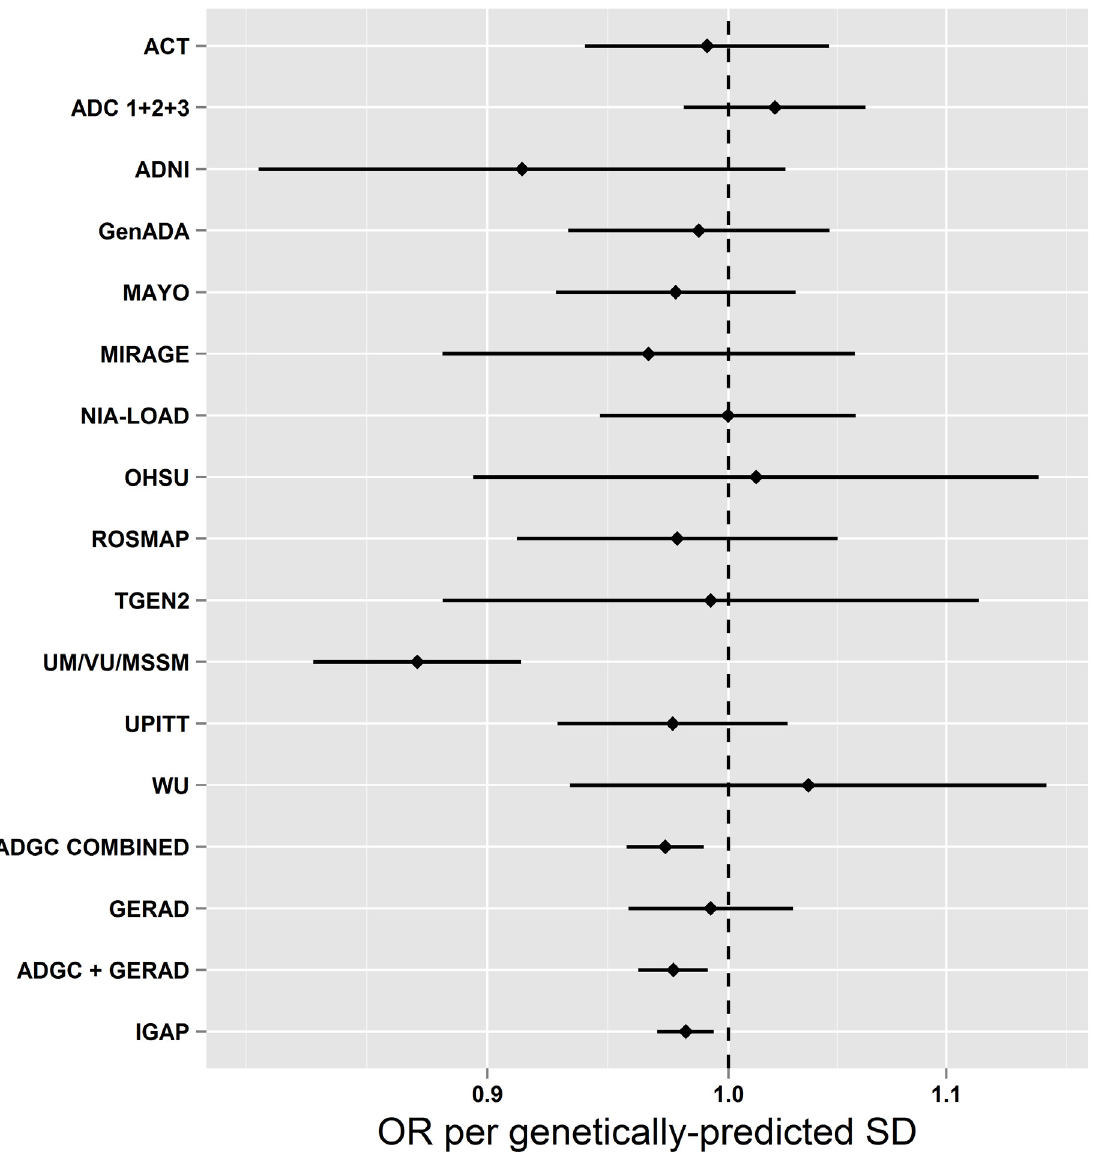
Fig 1. Mendelian randomization estimates of the association of systolic blood pressure with AD in individual ADGC studies and overall in ADGC, GERAD1, and IGAP. This figure shows MR estimates for the association of SBP-associated variants with AD in each of the participant studies in ADGC [24] and in GERAD1 [25] using individual SNP-level data compared to that observed in IGAP [12] using summary-level data. See S1 Text (supplemental results) for individual study name abbreviations.